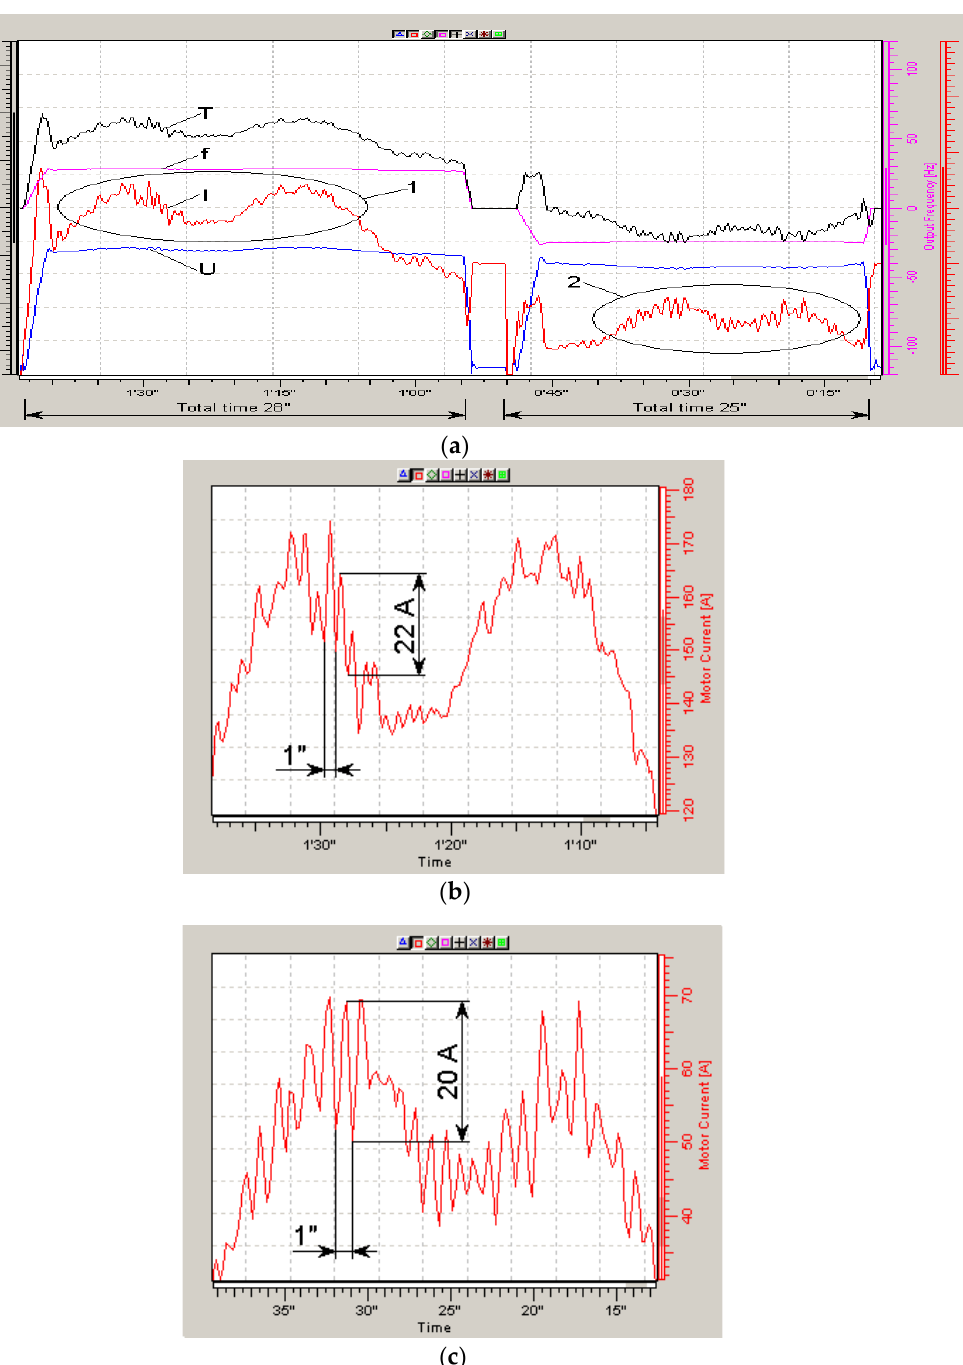
Figure 14. Diagrams of movement at high speed along track 4 with parameters U = 230 V, f = 17 Hz and U/f = 13.2 Fl ( a ) and extended sections 1 ( b ) and 2 ( c ) of the current diagrams.